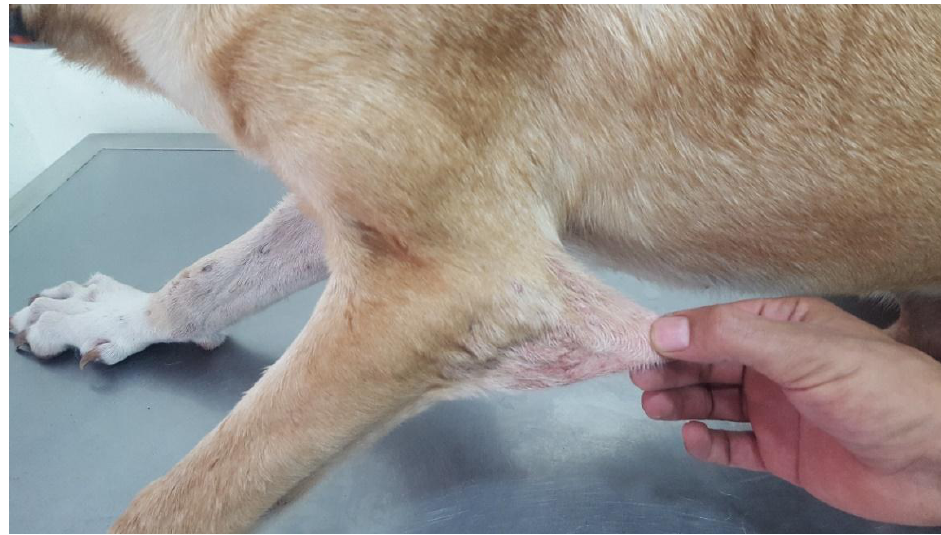
Figure 4. Case 2, Skin hyperextensibility over the elbow.